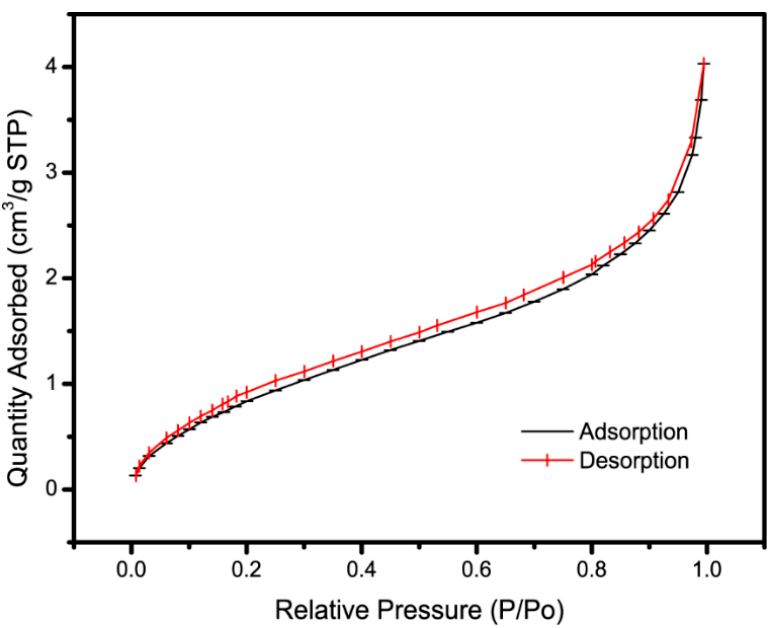
Figure 5. BET of CAG-GO20%.